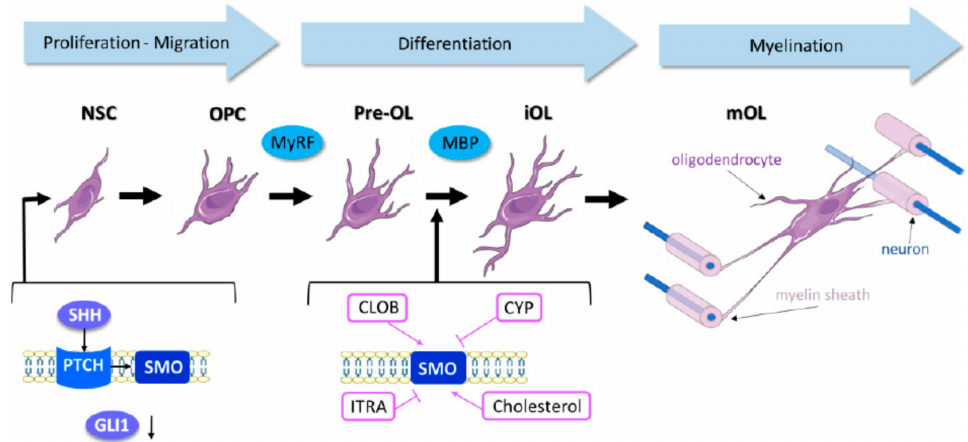
Figure 1. The role of Shh (Sonic Hedgehog) in neural stem cell (NSC) commitment to oligodendrocyte differentiation during remyelination. The process of oligodendrocyte maturation from NSCs to myelinating oligodendrocytes (mOL) requires Shh signaling reactivation. Smo activity seems to be crucial during the differentiation from premyelinating OLs (pre-OL) to immature oligodendrocytes (iOL). Smo agonists, such as Clobetasol (CLOB) or cholesterol, stimulate this passage while Smo inhibitors, such as cyclopamine (CYP) or itraconazole (ITRA), impair OL maturation via a poorly understood